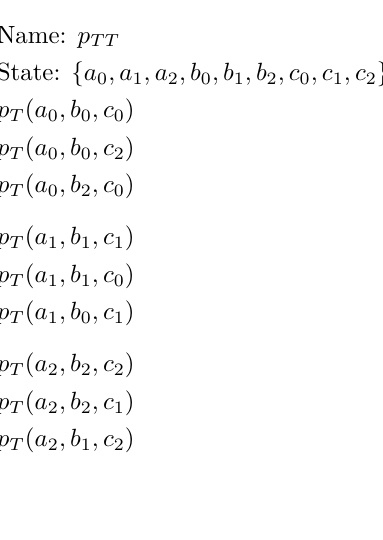
Figure 7: Algorithmic representation of masked Toffoli gate ( p TT ) using 3 shares.